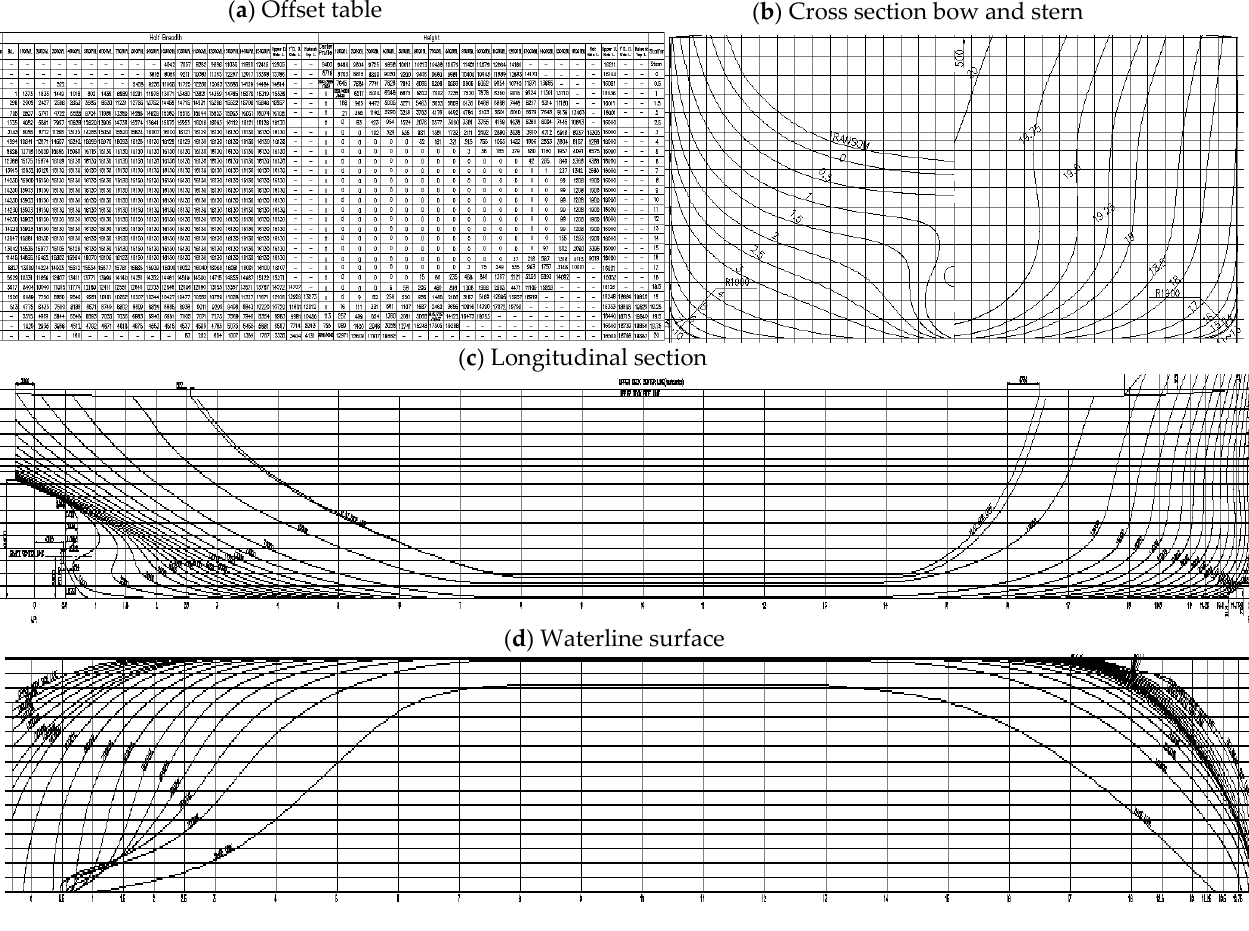
Figure 16. ( a ) Offset table and ship line diagram, which include ( b ) cross section bow, ( c ) longitudinal section and ( d ) waterline surface.